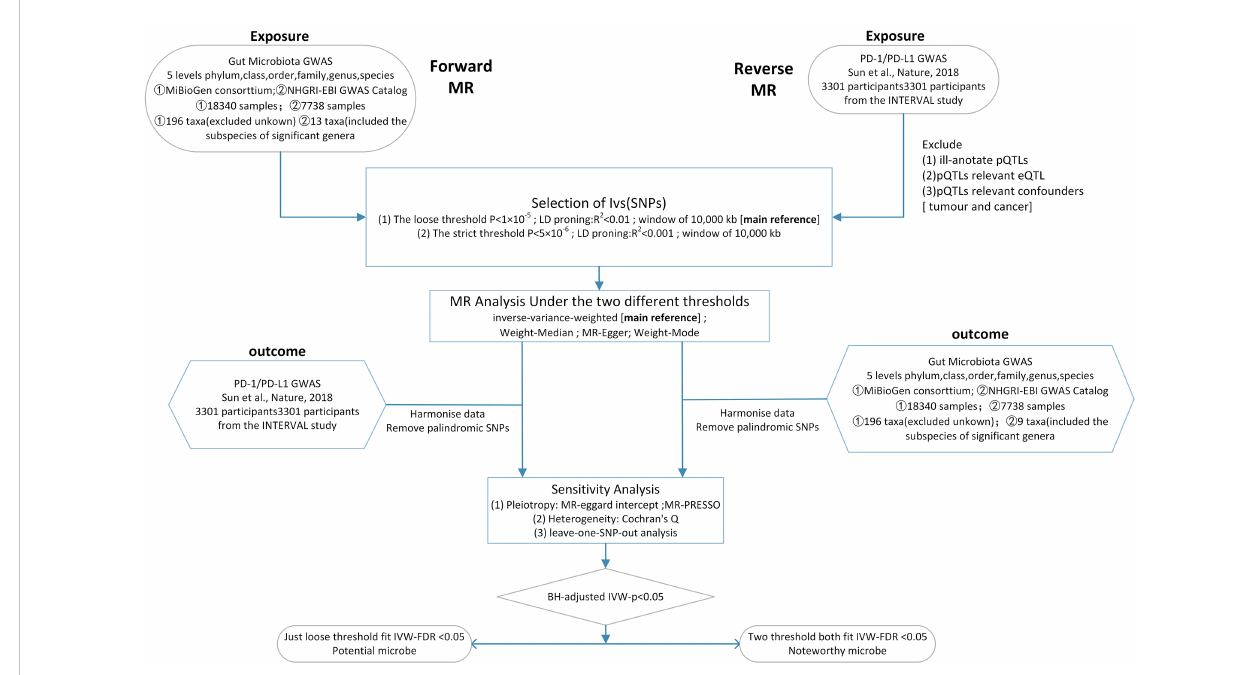
FIGURE 1 Work fl ow of this MR analysis. SNPs, single-nucleotide polymorphisms; MR, Mendelian randomization; LD, linkage disequilibrium; eQTL, expression quantitative trait loci; pQTL, protein quantitative trait